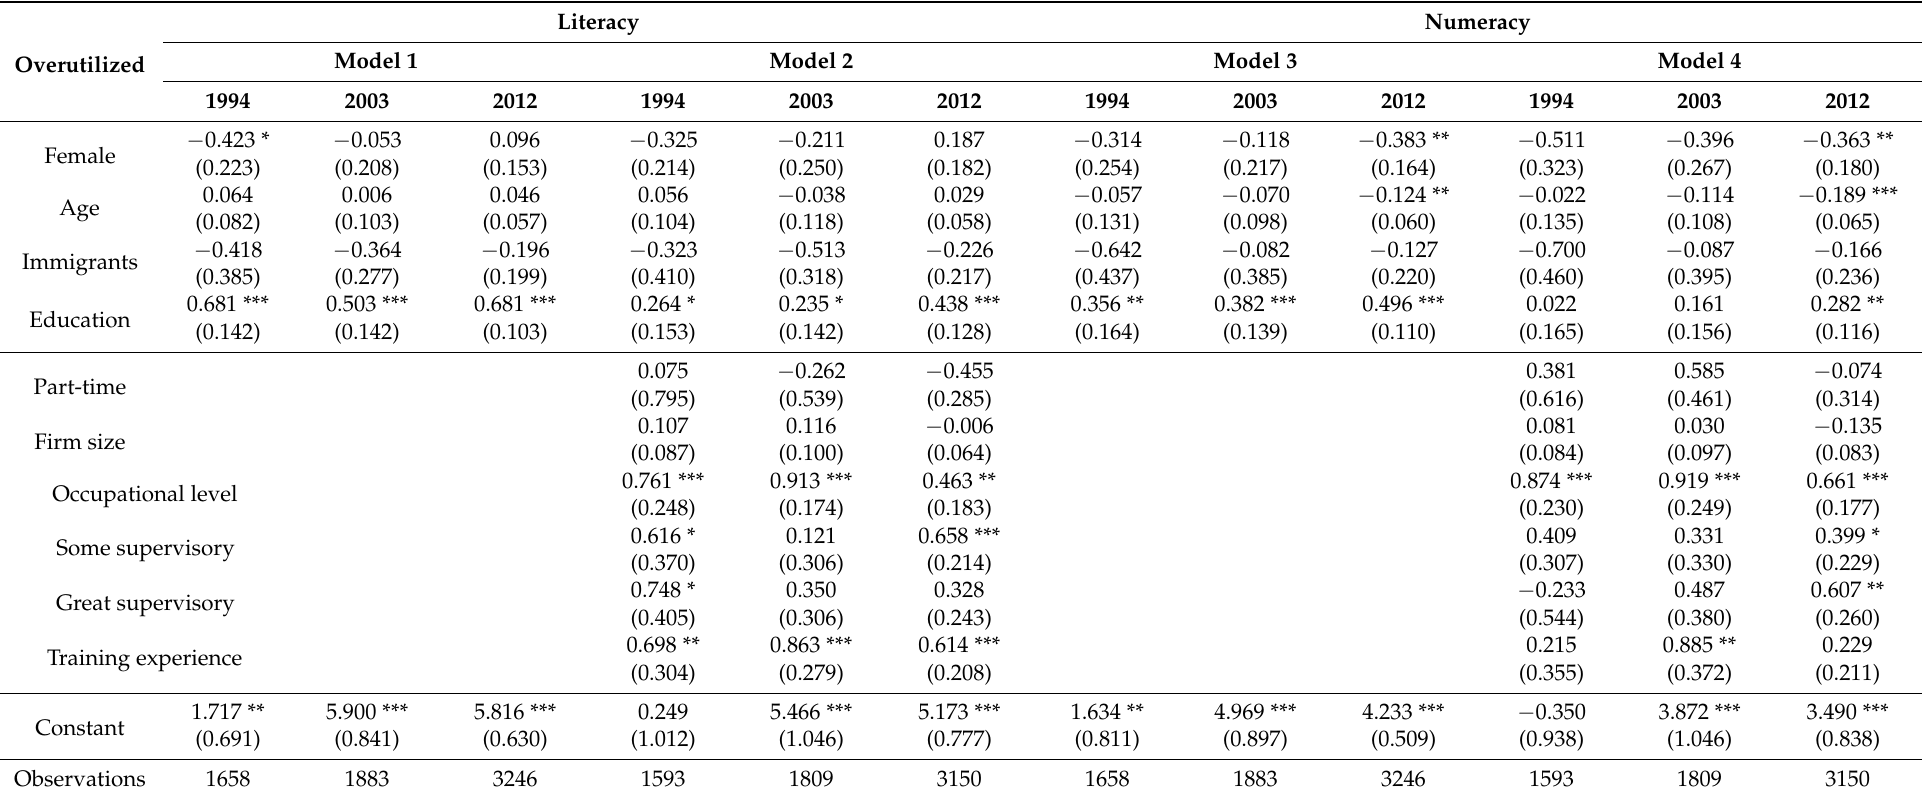
Table 4. Literacy and numeracy skill mismatch: overutilized vs.